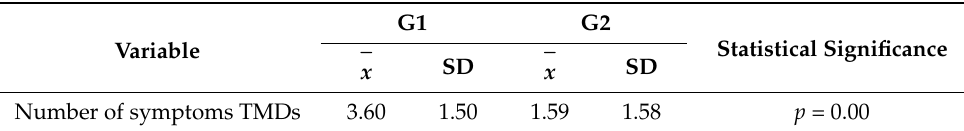
Table 2. Analysis of the number of TMD symptoms in relation to the presence and absence of the type D personality.